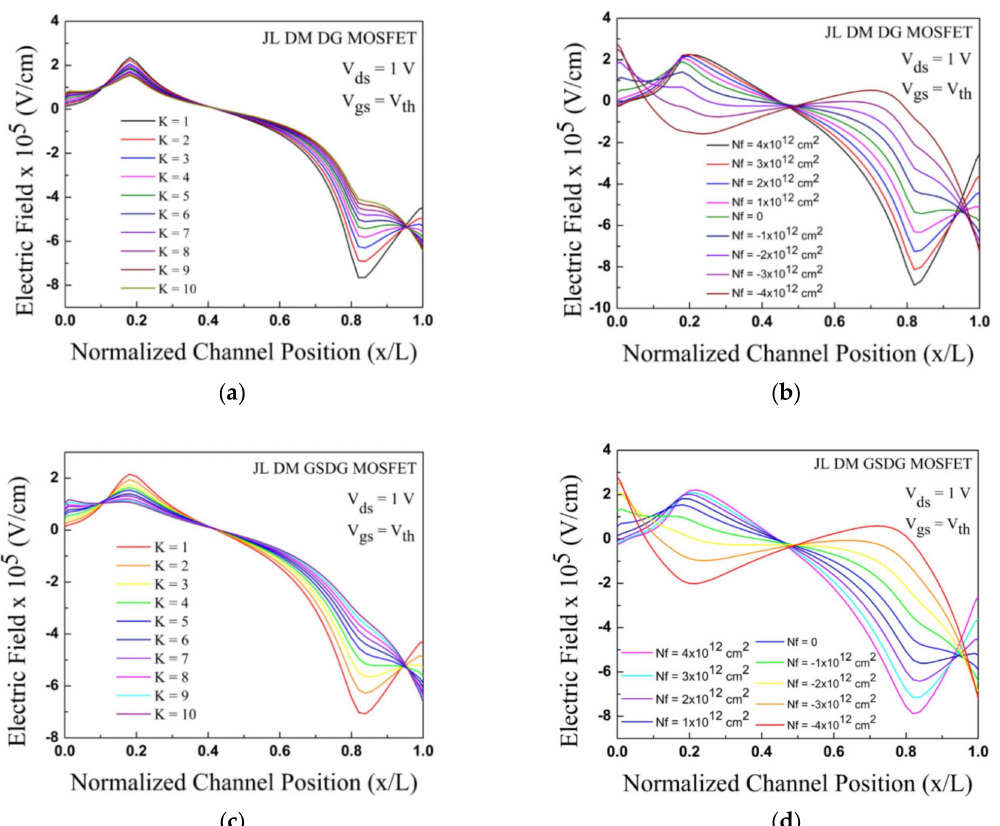
Figure 5. Variation in electric field along the channel: ( a ) effect of K on JL-DM-DG-MOSFET; ( b ) effect of charged biomolecules on JL-DM-DG-MOSFET; ( c ) effect of K on JL-DM-GSDG-MOSFET; ( d ) effect of charged biomolecules on